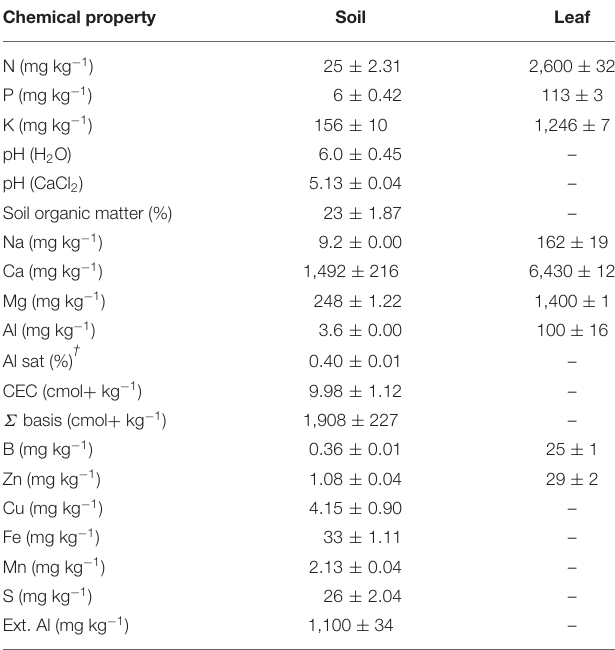
TABLE 1 | Chemical properties of soil (Typic Placudands, Freire Series) and European hazelnut leaves from the tested commercial hazelnut orchard (Fundo Caracas, Frutícola Agrichile S.A.) in Cunco, La Araucanía region,